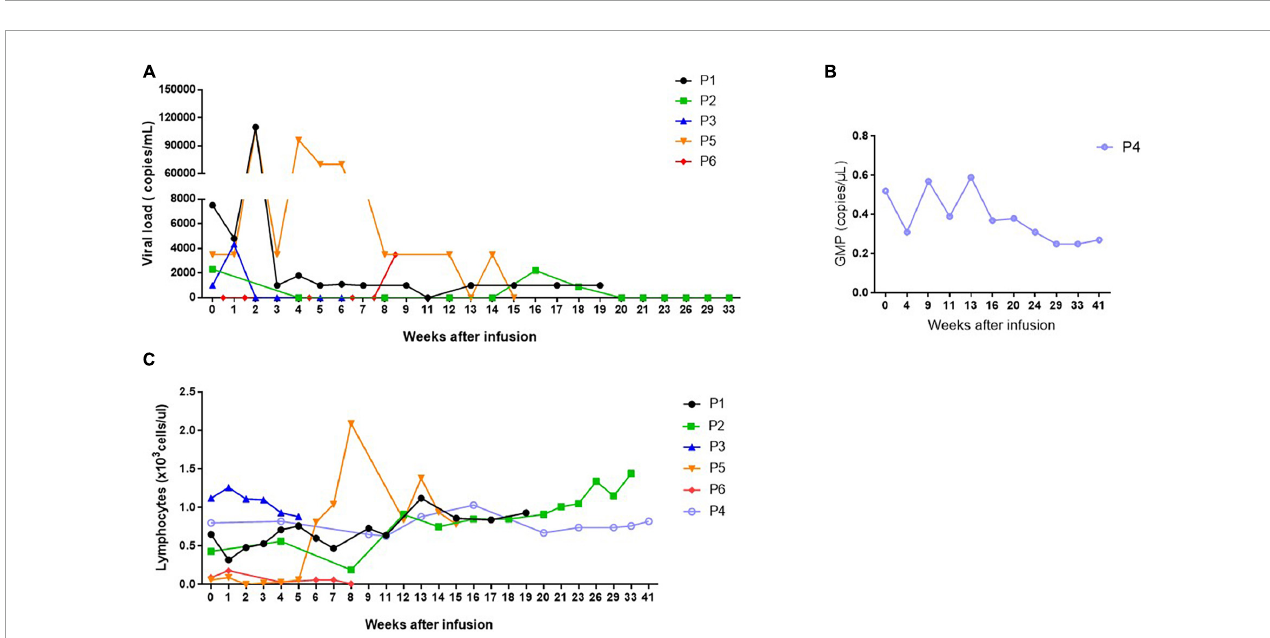
FIGURE3 Graphical representation of (A) viral load (copies/ml), (B) galactomannan (GMP) (copies/ µ l) and (C) lymphocyte ( × 10 3 cells/ µ l) progression while the infusions were performed. As expected, the viral load and GMP decrease with adoptive cell therapy with CD45RA − T-cell infusions containing pathogen-specific memory T cells, while lymphocyte count